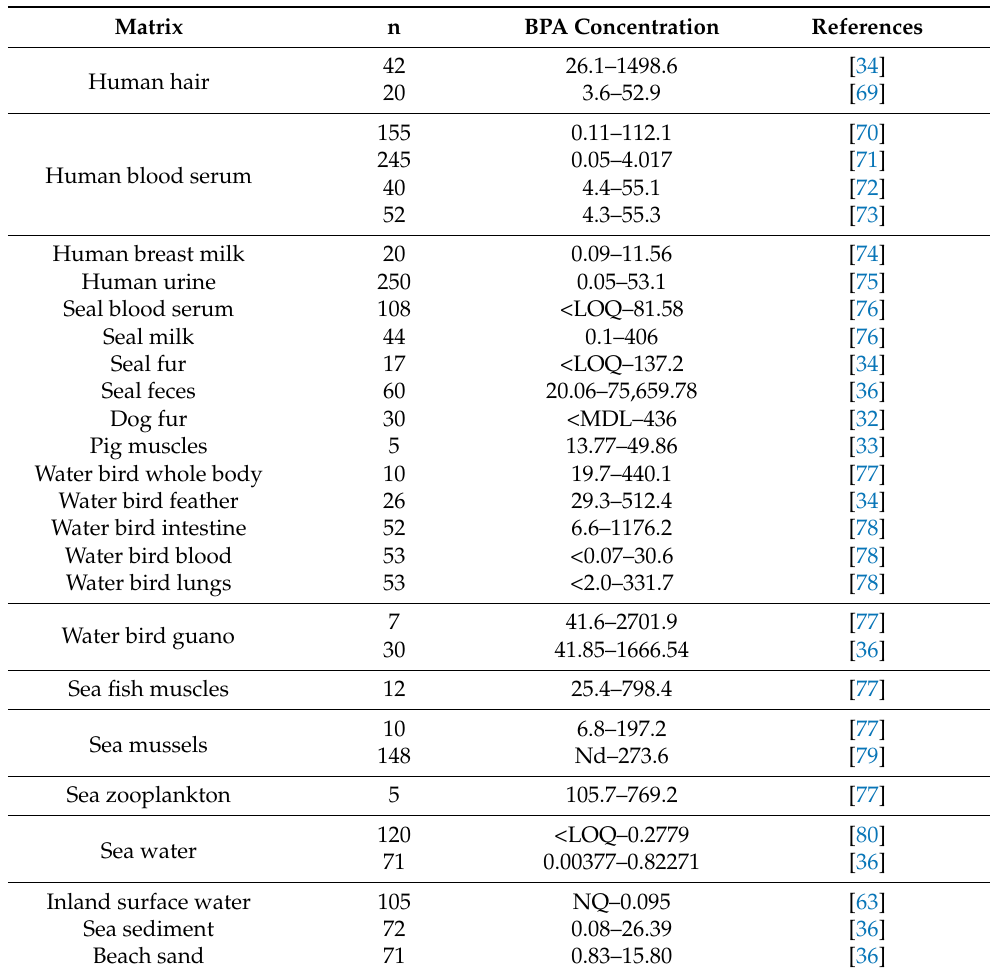
Table 6. Previous studies on BPA concentration levels (in ng/g for solid matrices and ng/mL in liquid matrices) in living organisms and environment in